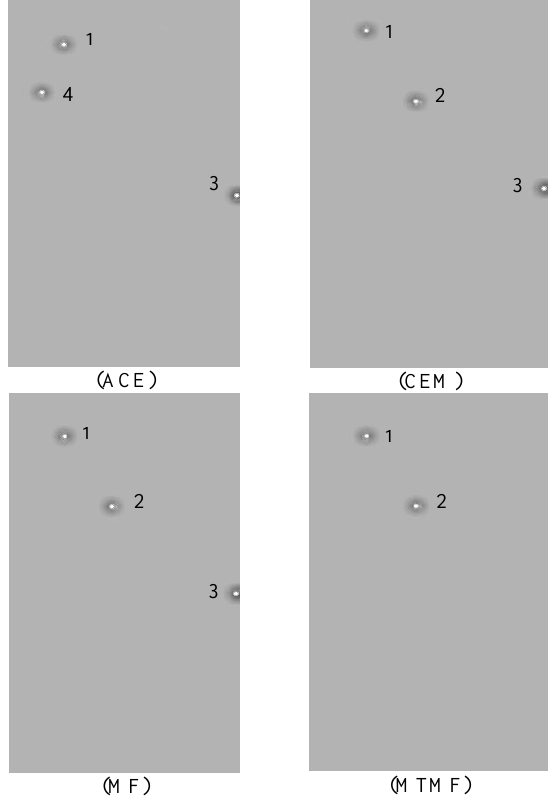
Figure 3. The final output is obtained as the result of applying various algorithms to detect hydrocarbon seepages on the Kamaron Hyperion image. White dots are expressing hydrocarbon seeps.